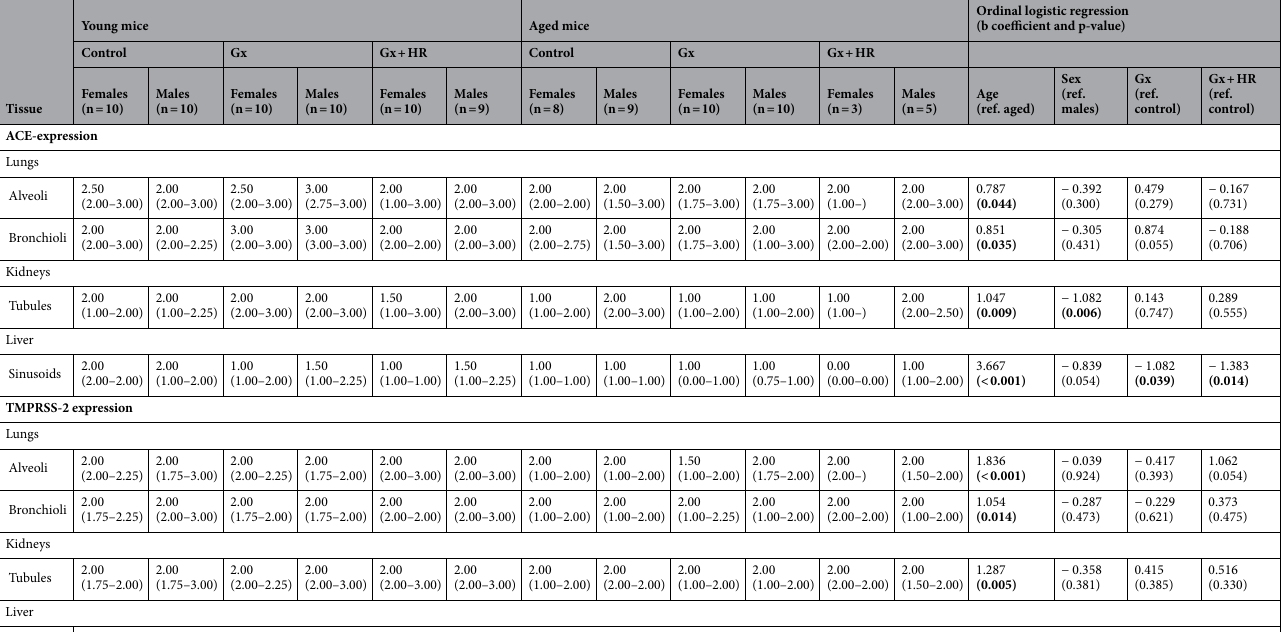
Table 2. Impact of age, sex and hormone deprivation/replacement status on ACE-2 and TMPRSS-2 expression after acute myocardial injury. Data are expressed as median (interquartile range). P-values were derived from ordinal logistic regression. Significant values are in bold. ACE-2, angiotensin-converting enzyme 2; Gx, gonadectomy; HR, hormone replacement; TMPRSS-2, transmembrane protease serine 2.